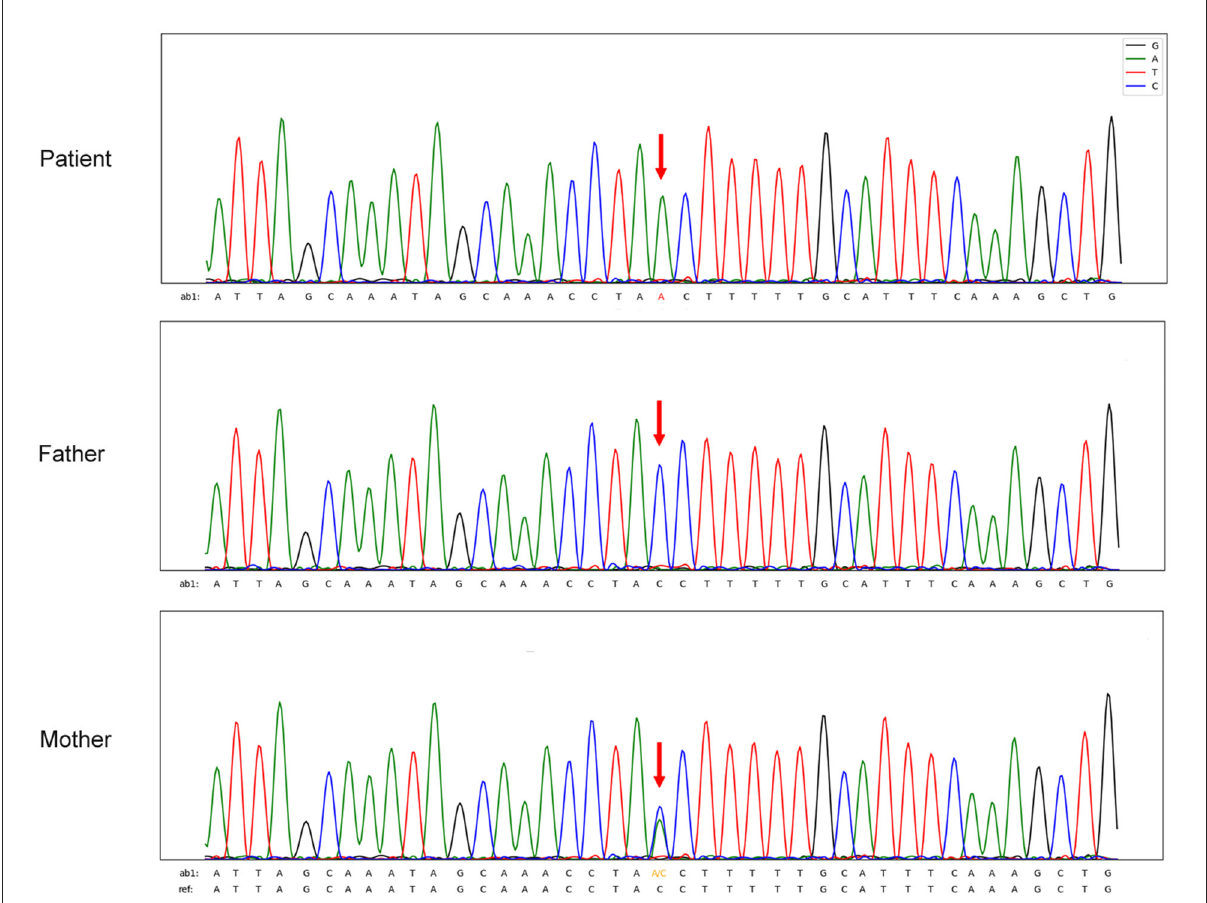
FIGURE3 Sequencing maps of CD40LG gene variants in the infant and his